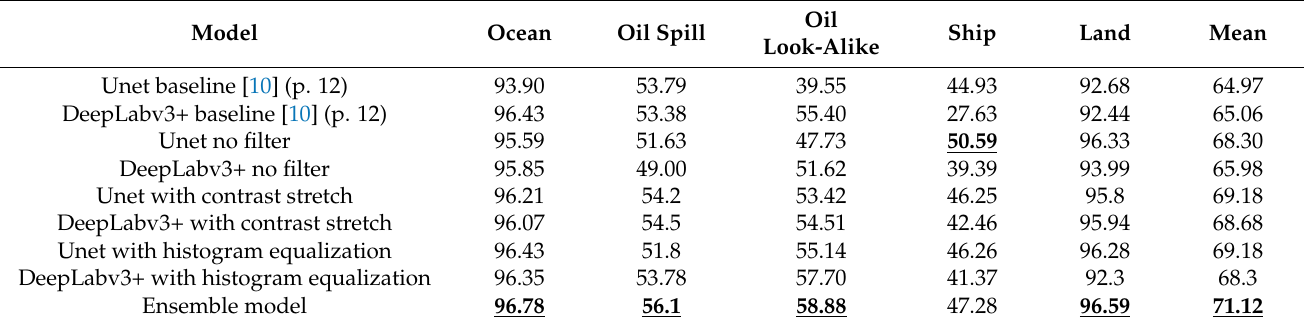
Table 2. Comparison of different filters on the segmentation results of the Unet and DeepLabv3+ in terms of